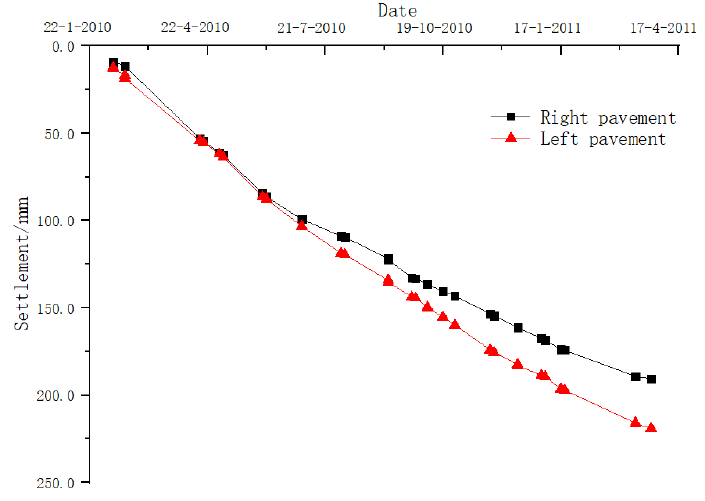
Figure 4. Total embankment settlement before improvement with FCB.